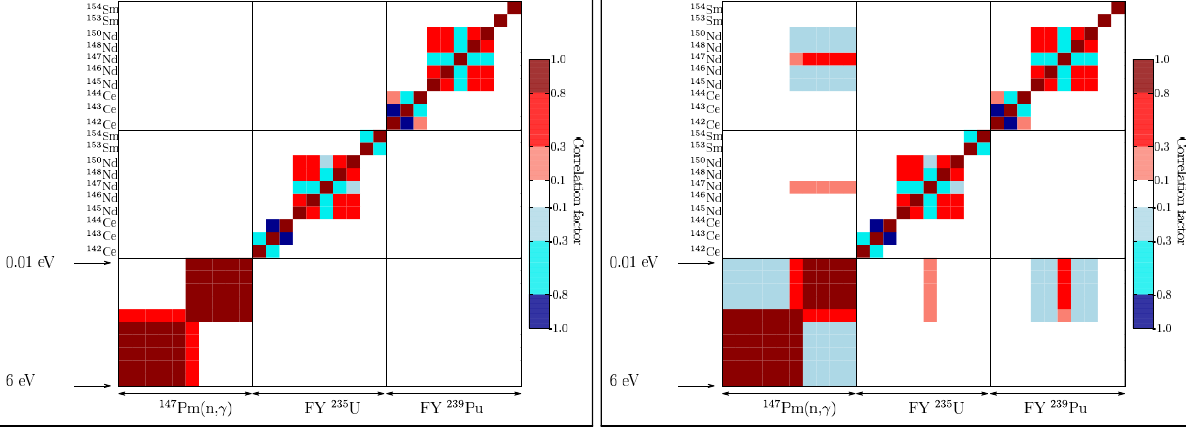
Fig. 4. Case of correlations between 147 Pm(n, γ ) and fission yields from 235 U and 239 Pu. Left: prior correlation matrix without PIE data; right: posterior correlation matrix using the PIE measurement from 147